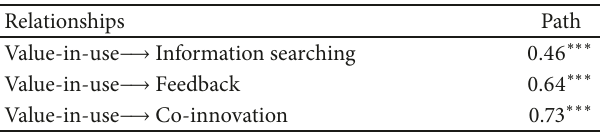
Table 5: Results of relationship